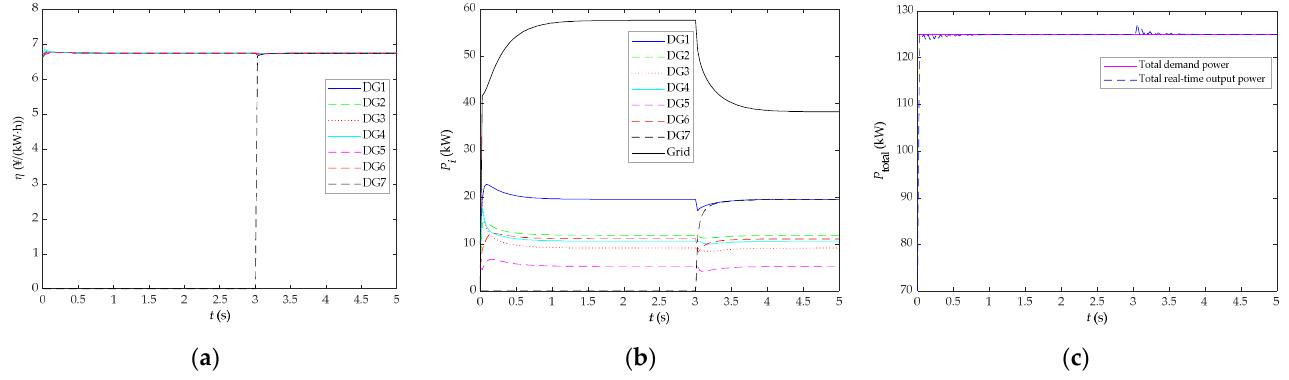
Figure 23. Change curves of variables of the system when the DG joins: ( a ) change curves of each DG’s ICR; ( b ) change curves of each DG’s active output and grid output power; ( c ) change curves of the cumulative sum of each DG’s active output and grid output power as well as total demand power.